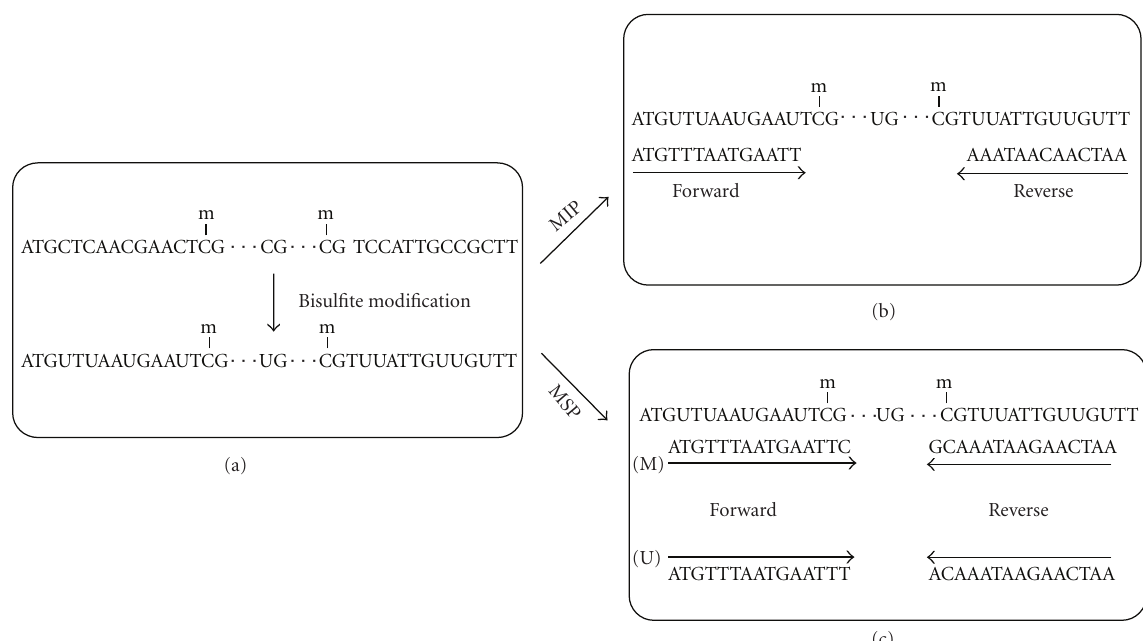
Figure 1: Primer design for DNA methylation profiling techniques based on bisulfite conversion. (a) First DNA is treated with sodium bisulfite to convert all unmethylated cytosines to uracil. To analyze DNA methylation status of the interest genes, converted DNA is amplified based on two di ff erent primer designing strategies: methylation-independent specific PCR (MIP) and methylation-specific PCR (MSP). (b) In MIP, DNA molecules are amplified using primer pairs containing cytosines (no-CpG) in their sequence. (c) In MSP, primer pairs are designed to specifically amplify either methylated (M) or unmethylated (U) DNA by containing CpG site in their sequence that makes possible to distinguish the methylated sequence from the unmethylated